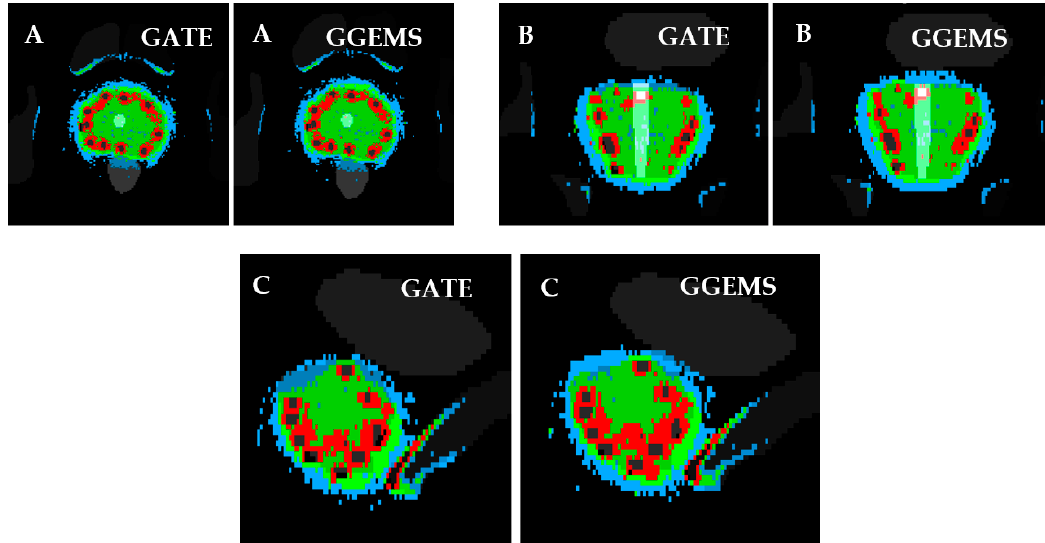
Figure 7. Simulation of a clinical case with 67 Amersham Health 6711 seeds in a prostate. Dose maps are shown for both toolkits ( A ) GATE and ( B ) GGEMS. White stands for maximum absorbed dose (100%). In ( C ) a profile comparison is depicted for both simulation tools. The line seen on ( A ) and ( B ) images is the region where the dose profile is taken.